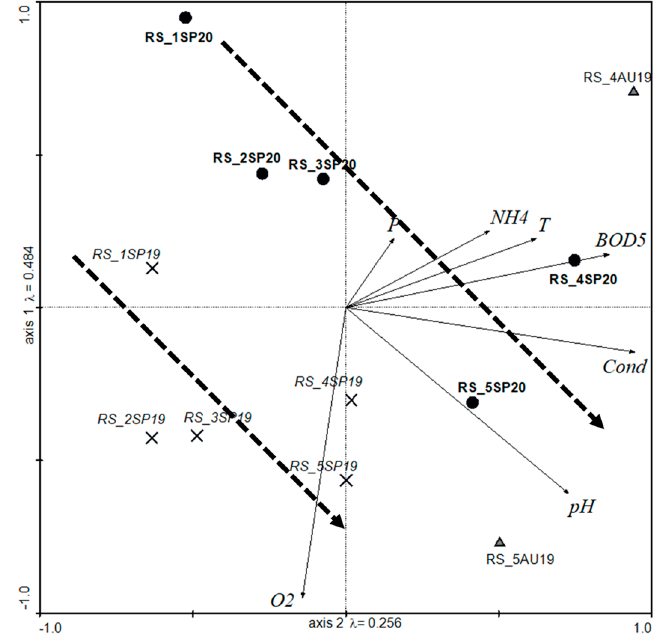
Figure 2. PCA biplot of sampling sites and environmental variables analyses ( → ). The variables are represented by arrows (T-temperature; pH; Cond-conductivity; O 2 -oxygenation; NH 4 -ammoniacal nitrogen; P-total phosphorus). The sampling site codes correspond to each of the five points (Figure 1) in each data collection. Dashed arrows indicate a gradient along the sampling sites observed with an increase in oxygen and pH values.